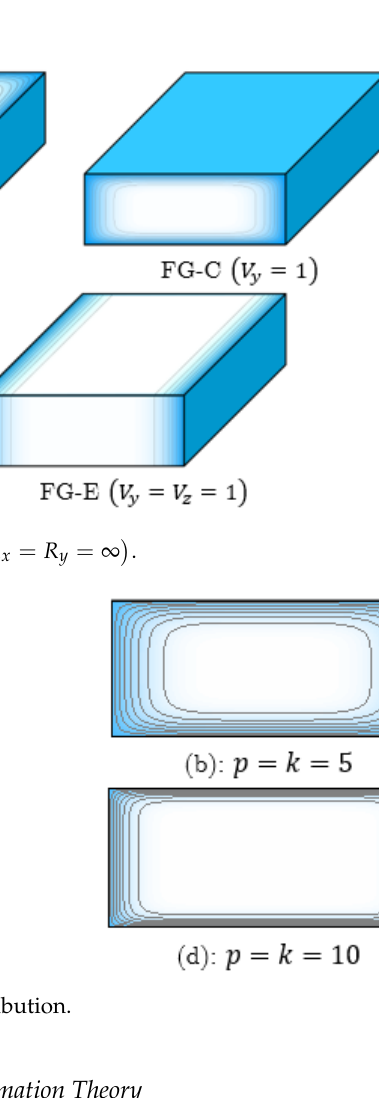
Figure 1. FG spherical shell geometry.